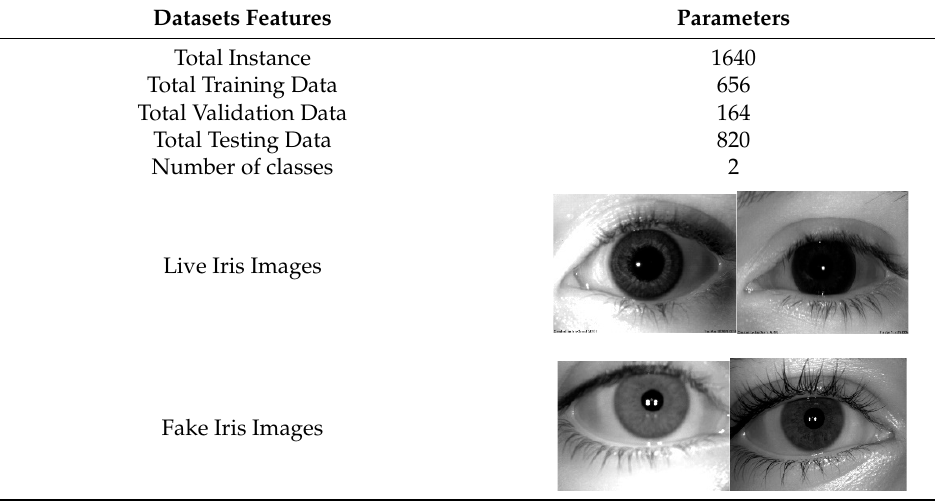
Table 3. ND_Iris3D_2020 dataset description.